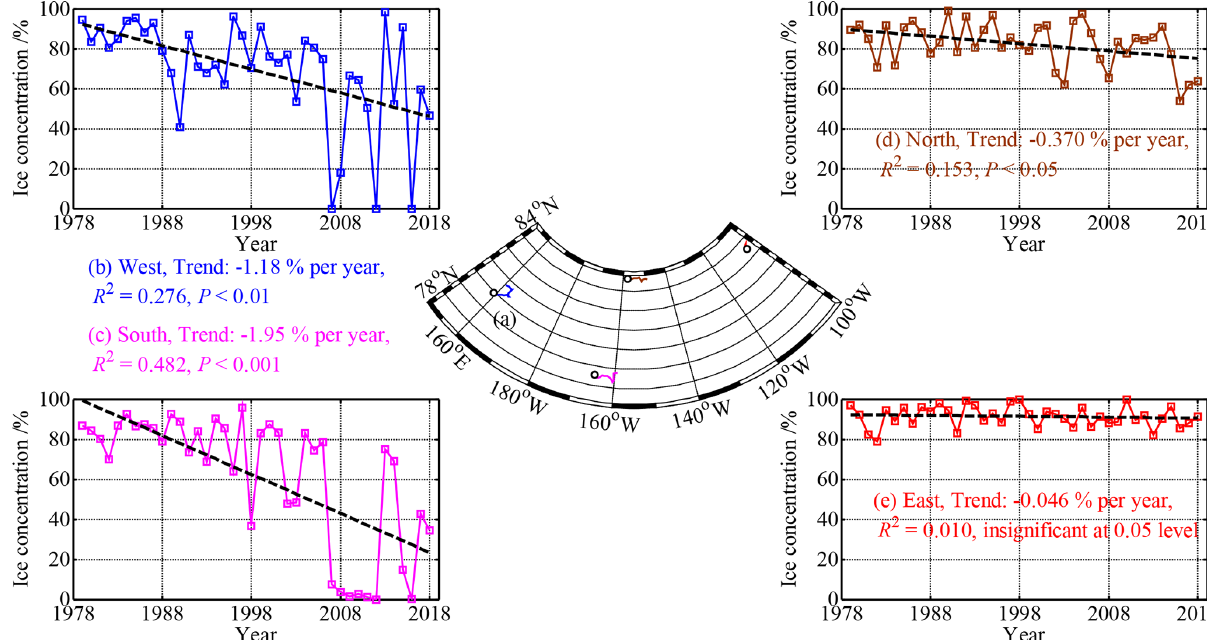
Figure 16. (a) Drift trajectories of the westernmost, southernmost, near-northernmost, and easternmost buoys from 1 to 15 September 2018; the northernmost buoy has been omitted because it drifted to the north of 84.5 ◦ N, where SMMR ice concentration data prior to 1987 are unavailable. The trajectory of the westernmost buoy was reconstructed using the NSIDC ice motion product because this buoy was deployed on 15 September 2018. (b–e) Long-term changes in ice concentration along buoy trajectories averaged over 1–15 September, with black lines denoting linear